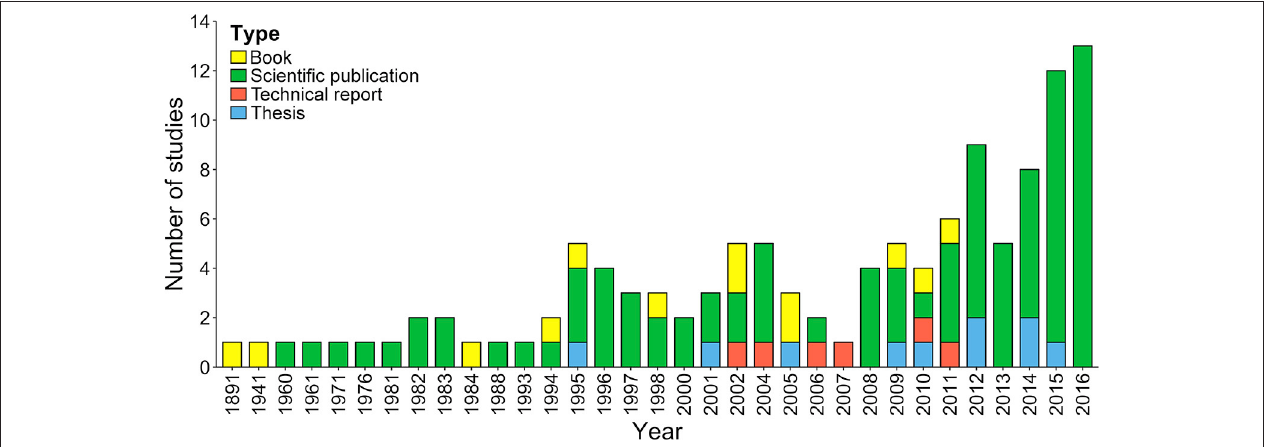
FIGURE 2 | Number and type of studies published on Chondrichthyan fishes in Costa Rica.